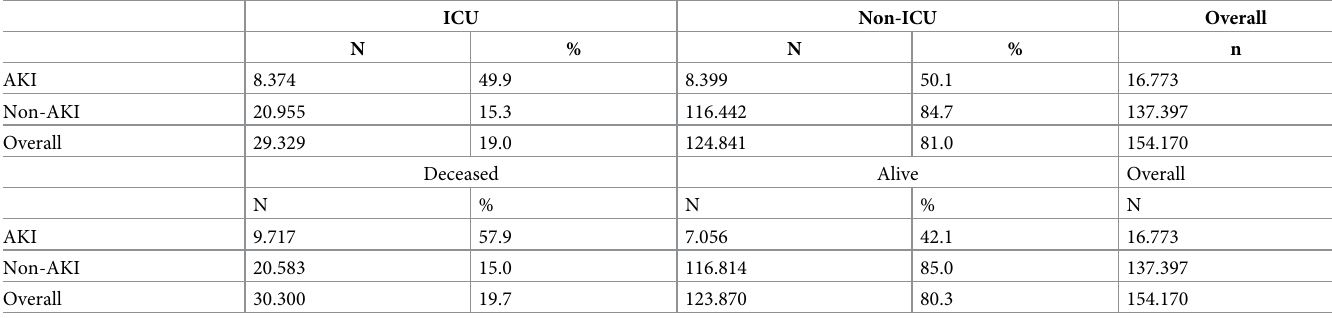
Table 3. Contingency table for AKI and risk of ICU admission or in-hospital